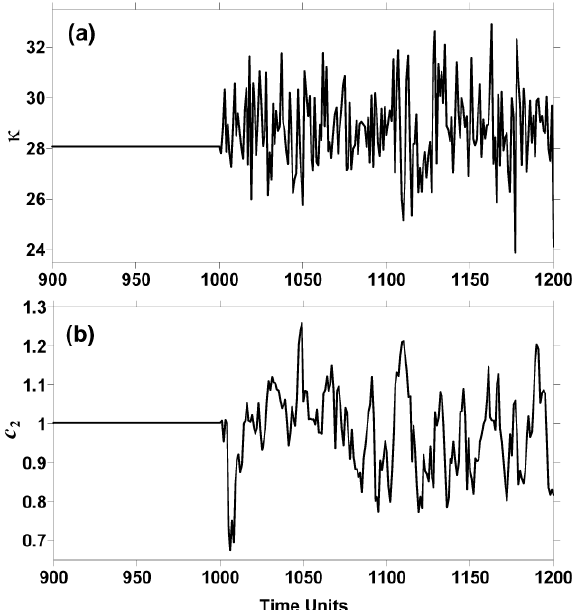
Fig. 5. Time series of ensemble means of (a) κ and (b) c 2 between 900 and 1200TUs in PP_PO.